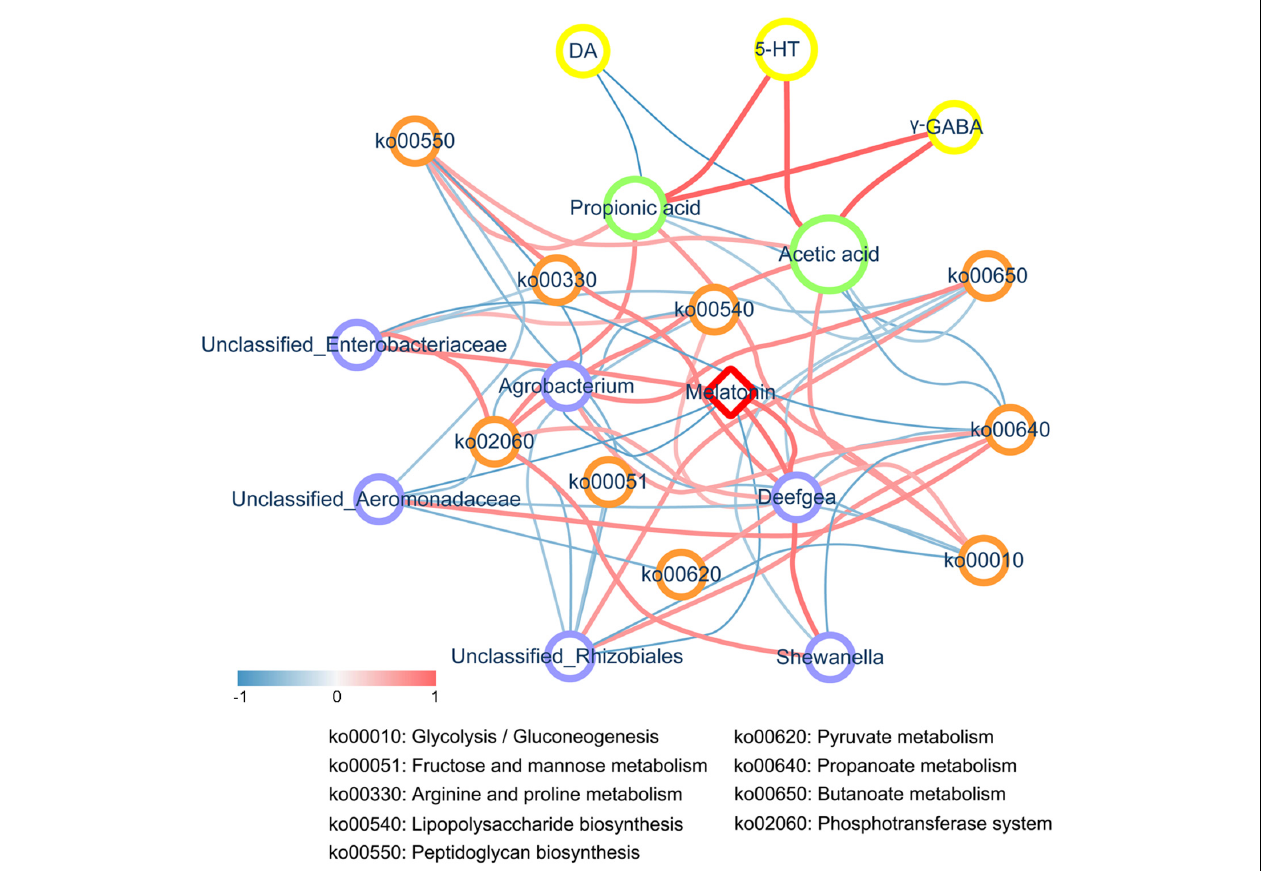
FIGURE 6 | Correlation network analysis. The correlation network constructed among melatonin, differentially abundant genera, metabolic pathways, SCFAs, and neurotransmitters (including DA, γ -GABA, and 5-HT) based on Spearman’s rank correlation coefficient. An R < -0.4 or > 0.4 was selected. The width and color (the red indicates a positive correlation, while the blue indicates a negative correlation) of the edge are proportional to the correlation intensity. The red node represents melatonin, blue nodes represent genera, orange nodes represent metabolic pathways, green nodes represent SCFAs, and yellow nodes represent neurotransmitters. The node size is proportional to the mean abundance in the respective